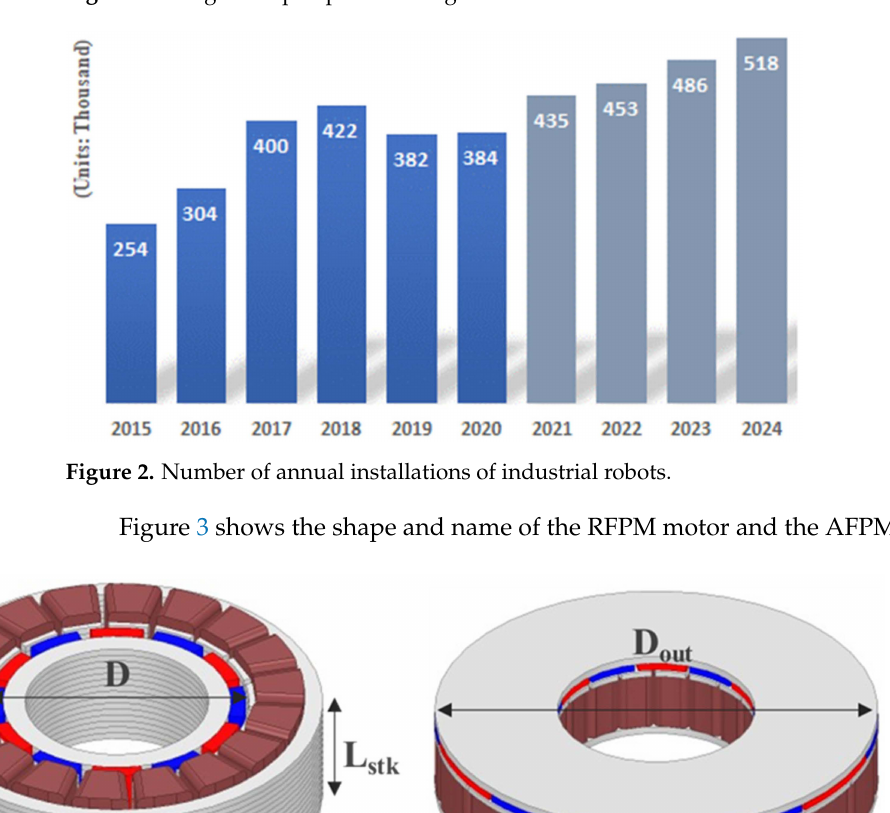
Figure 1. The growth prospects of the global robot market.